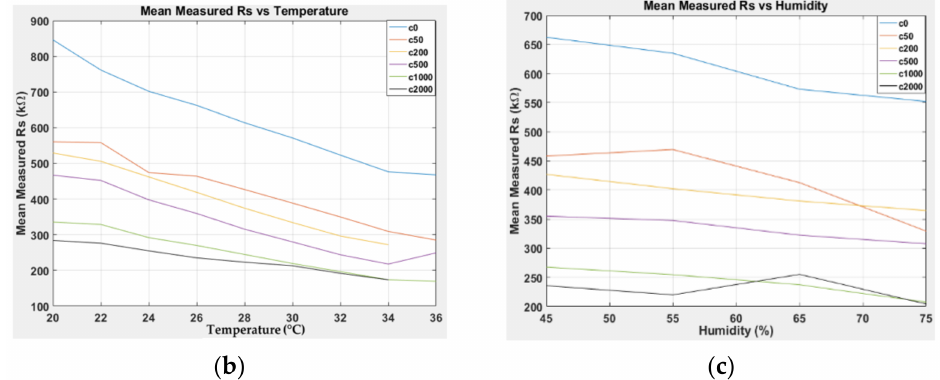
Figure 9. ( a ) Three-dimensional surface graph of GM-502B measured R S at varying temperature and humidity levels and different ethanol solution concentrations, ( b ) mean of measured R S versus temperature, and ( c ) mean of measured R S versus humidity.